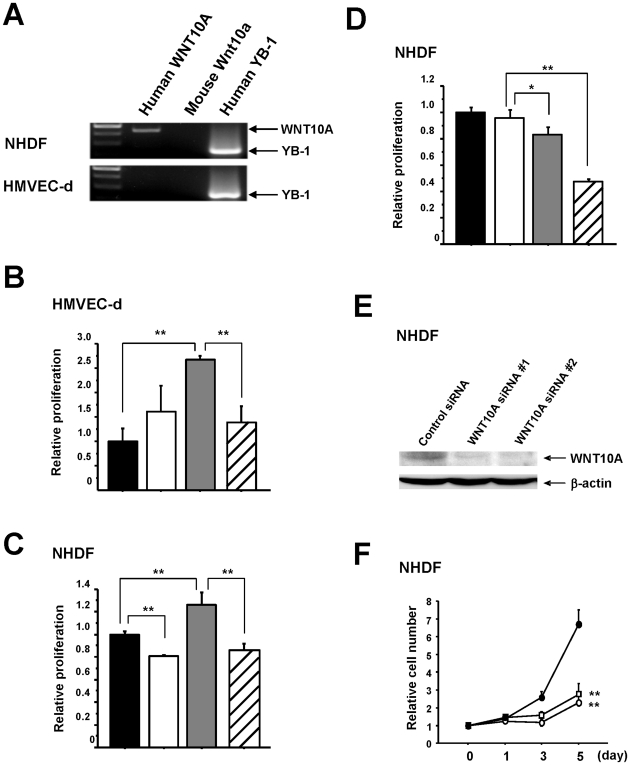
WNT10A is expressed in fibroblast cells and functions as an angio/stromagenesis growth factor in vitro.(A) RT-PCR for human WNT10A mRNA in NHDF and HMVEC-d cells. Human YB-1 was used as a positive control and mouse Wnt10a was used as a negative control. (B), (C) WNT10A-dependent growth of HMVEC-d and NHDF cells. For the proliferation assays using BrdU incorporation, HMVEC-d (NHDF) cells were cultured in conditioned medium (CM) with or without WNT10A antibody for 24 hours (black bar; Control-CM, white bar; Control-CM + WNT10A antibody 5 µg/ml, gray bar; WNT10A-CM, slash bar; WNT10A-CM + WNT10A antibody 5 µg/ml). **P<0.01. n = 3 per groups. (D) WNT10A-dependent autocrine growth of NHDF cells. NHDF cells were cultured with the recommended medium (RM) with or without WNT10A antibody (black bar; RM, white bar; RM + IgG 5 µg/ml, gray bar; RM + WNT10A antibody 2 µg/ml, slash bar; RM + WNT10A antibody 5 µg/ml). *P<0.05 and **P<0.01. n = 3 per groups. (E) Complete knockdown of WNT10A expression in NHDF cells is achieved using the two siRNAs against WNT10A. Whole-cell extracts (100 µg) were subjected to SDS-PAGE, and Western blotting analysis was performed using the indicated antibodies. (F) Knockdown of WNT10A suppresses the growth of NHDF cells (Control siRNA; closed circle, WNT10A siRNA #1; open square, WNT10A siRNA #2; open circle). **P<0.01 compared with the control siRNA group.